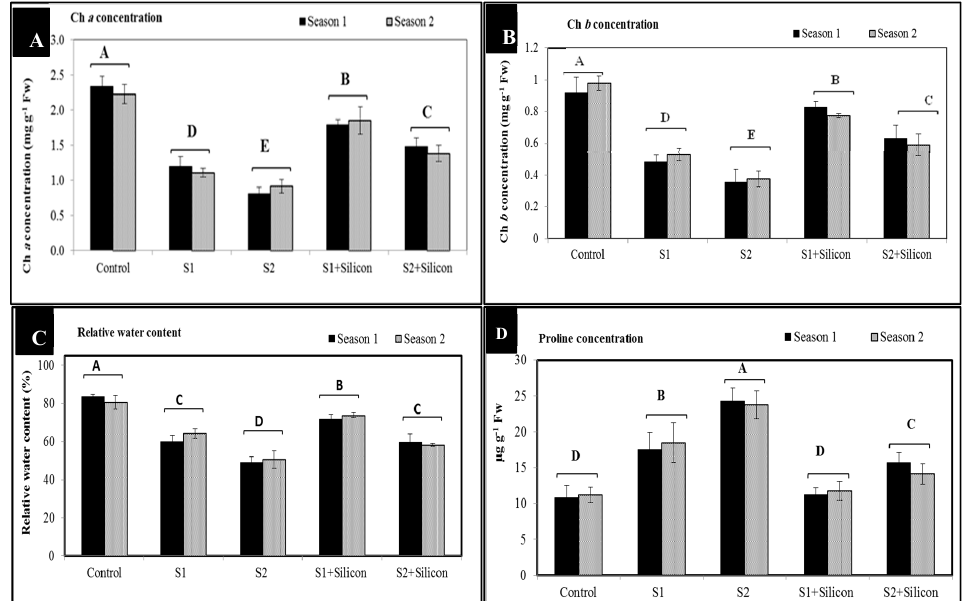
Figure 1. Effects of silicon on concentrations of chlorophyll a ( A ), chlorophyll b ( B ), relative water content ( C ), and proline ( D ) in sweet pepper plants under salinity stress in the 2018 and 2019 seasons. Bars followed by different letters are significantly different according to Duncan’s multiple range tests (DMRTs) at p < 0.05. S1: Salinity at 1500 ppm, S2: Salinity at 3000 ppm.